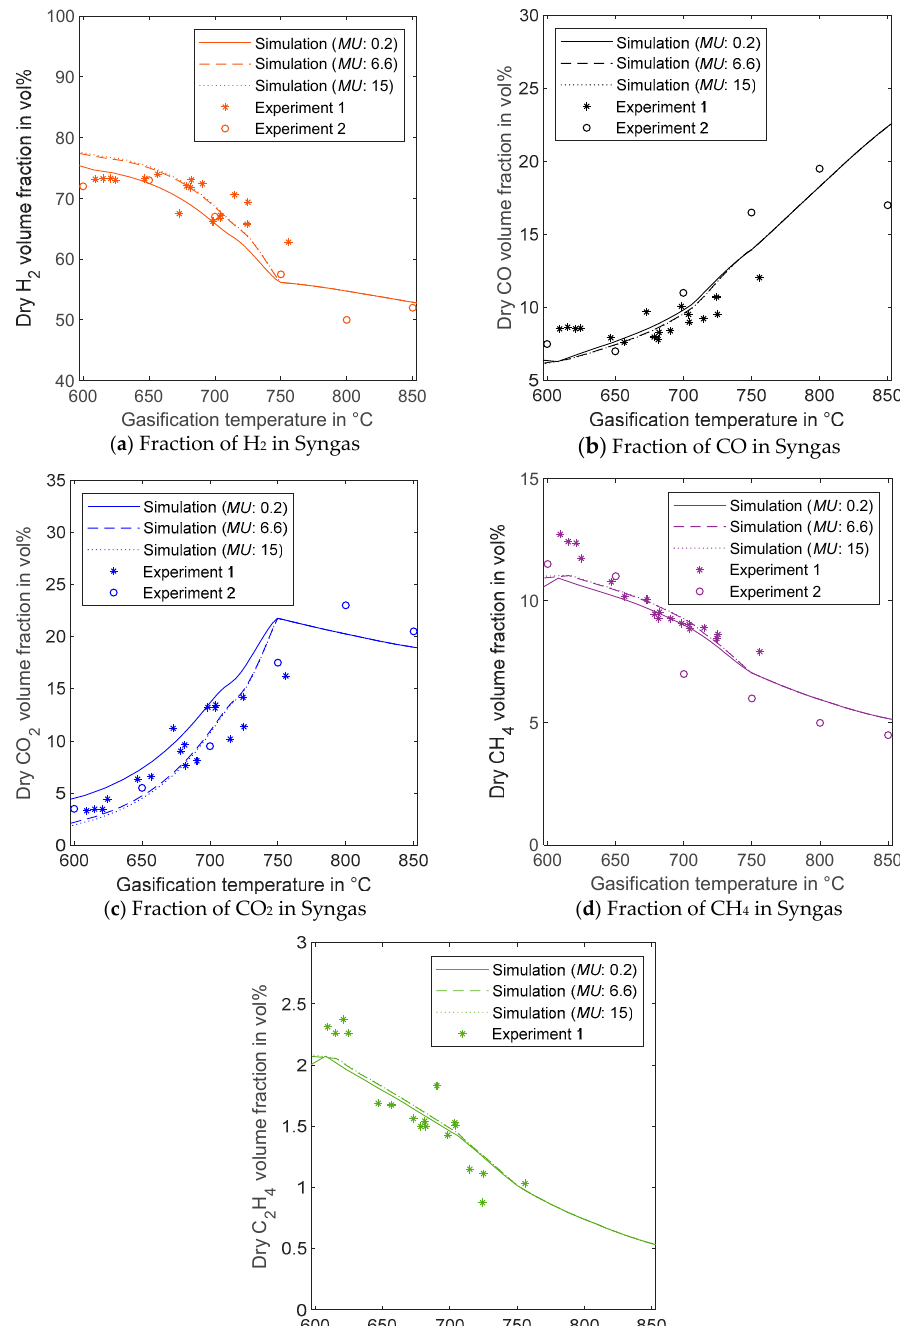
Figure 7. ( a – e ) Simulated syngas components: ( a ) H 2 , ( b ) CO, ( c ) CO 2 , ( d ) CH 4 , and ( e ) C 2 H 4 for gasification temperatures in the range of 600–850 °C (lines for limestone make-up of 0.2, 6.6, and 15 kg/h); comparison with experimental results from 200 kW (Experiment 1) and 20 kW (Experiment 2) DFB systems (data points).